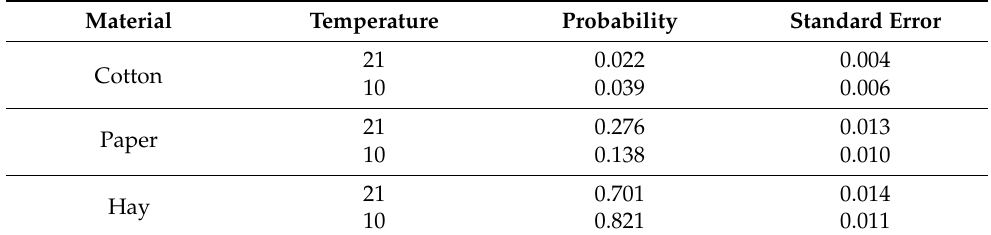
Table 3. The predicted probability of nest selection estimated by